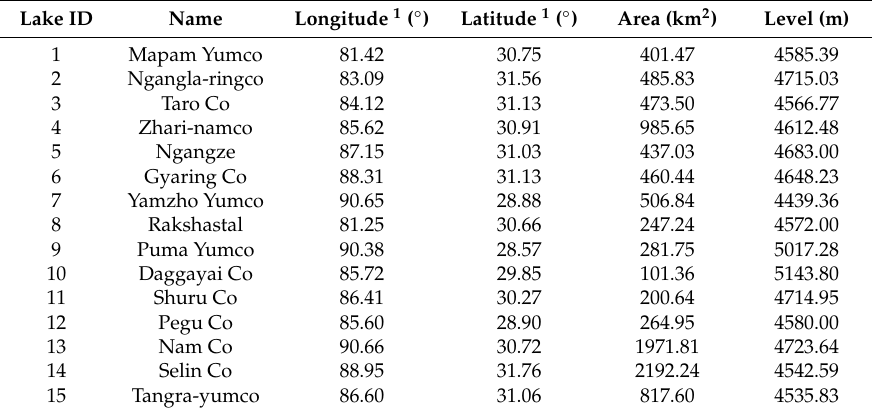
Figure 1. Spatial distribution of the 15 studied lakes and watersheds, paths of Ice, Cloud, and Land Elevation Satellite (ICESat) and ENVIromental SATellite (Envisat) altimeter data and metrological stations in the study area. Symbols near lake ID numbers indicate trends in the area. Up arrows indicate increases, down arrows indicate decreases, and N means no obvious change. Table 1. Characteristics of the studied lakes on the southern Tibetan Plateau (TP).